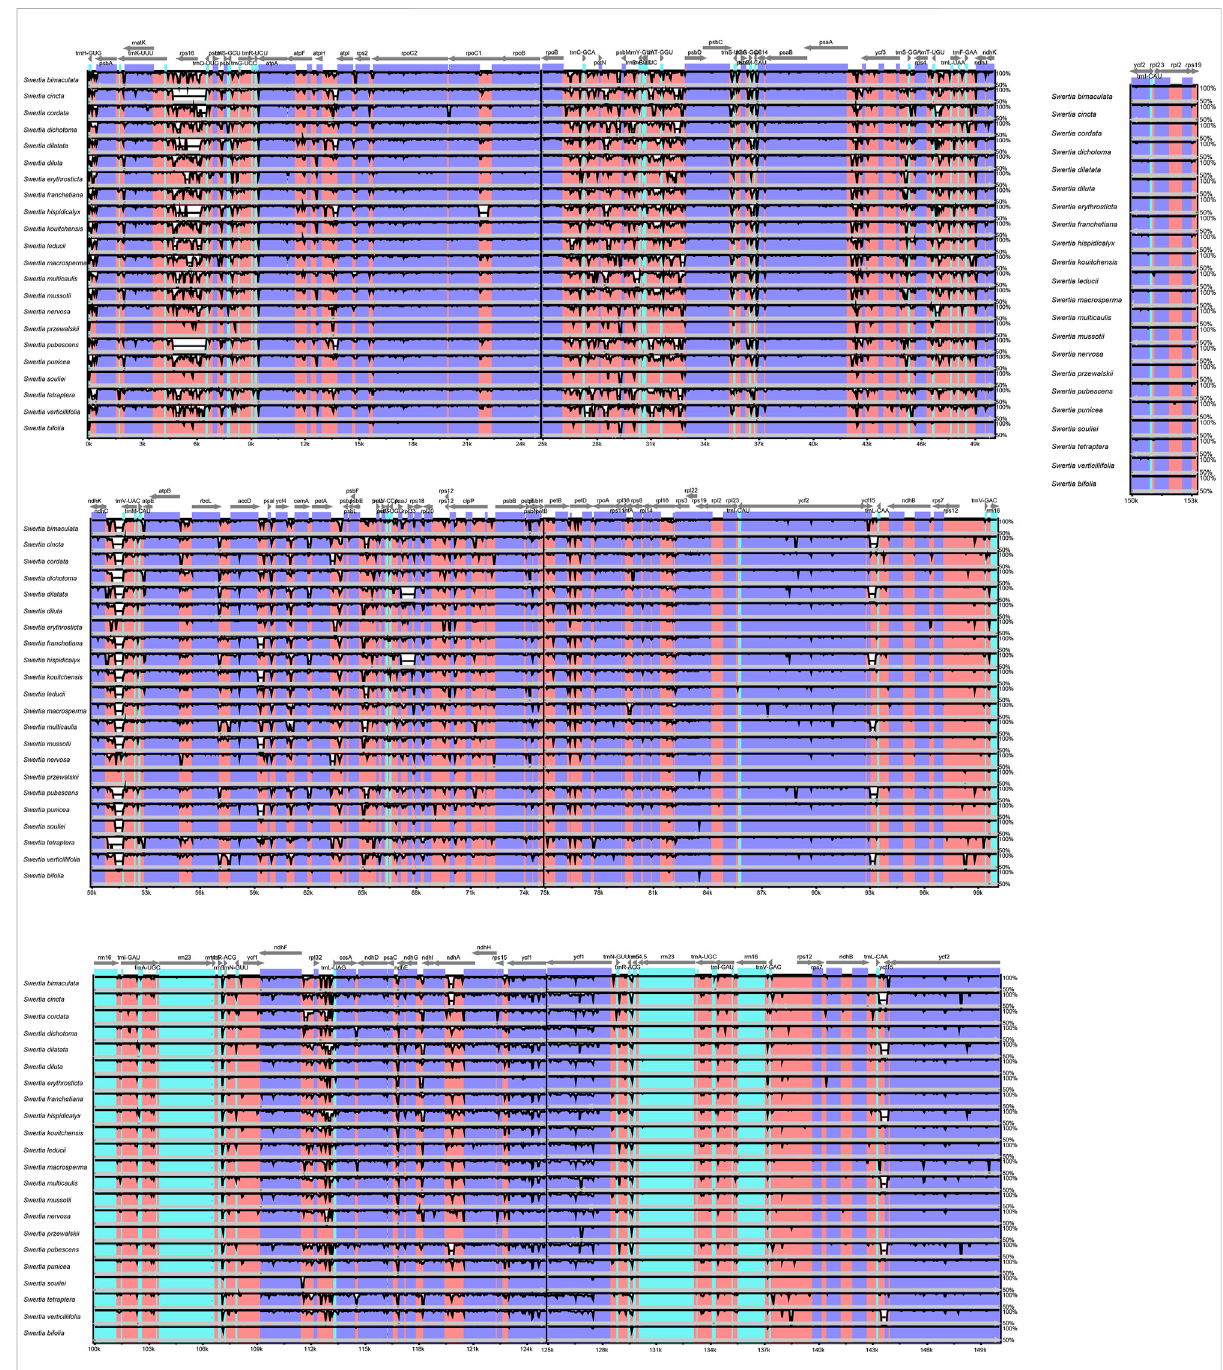
FIGURE 4 Comparison and analysis based on chloroplast genome of 23 Swertia L. species. Orientation of genes was pointed out by arrows up the alignments.Purple, blue, pink, andgreybarscorrespondto exons, untranslated regions, non-coding sequences, and mRNA,respectively. The Y -axis indicates the genetic similarity percentage. Genetic similarity among 50% – 100% were showed in the fi gure (for interpretation of the references to color in this fi gure legend, the reader is referred to the web version of this